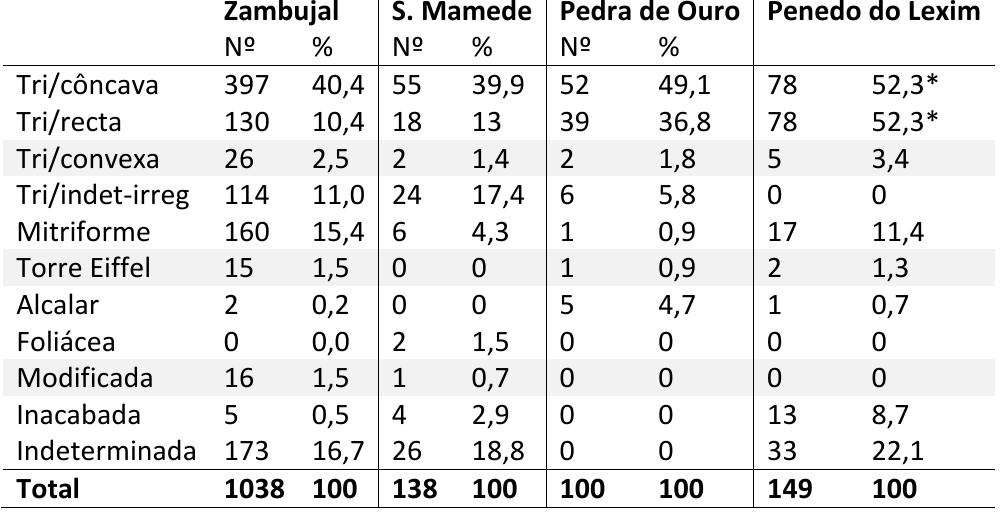
Tabela 1. Morfologia dos bordos das pontas de seta do Zambujal, S. Mamede, Pedra de Ouro e Penedo do os sítios. Nota: * Valores dos parâmetros determinados em conjunto . Table 1. Zambujal, S. Mamede, Pedra de Ouro & Penedo do Lexim arrow points morphology of the edges. With “Tri/côncava”and “Tri/recta” values determined in groups of homogene form to all the sites. Abbreviations: * Parameters values determined in group (Sousa 2011: